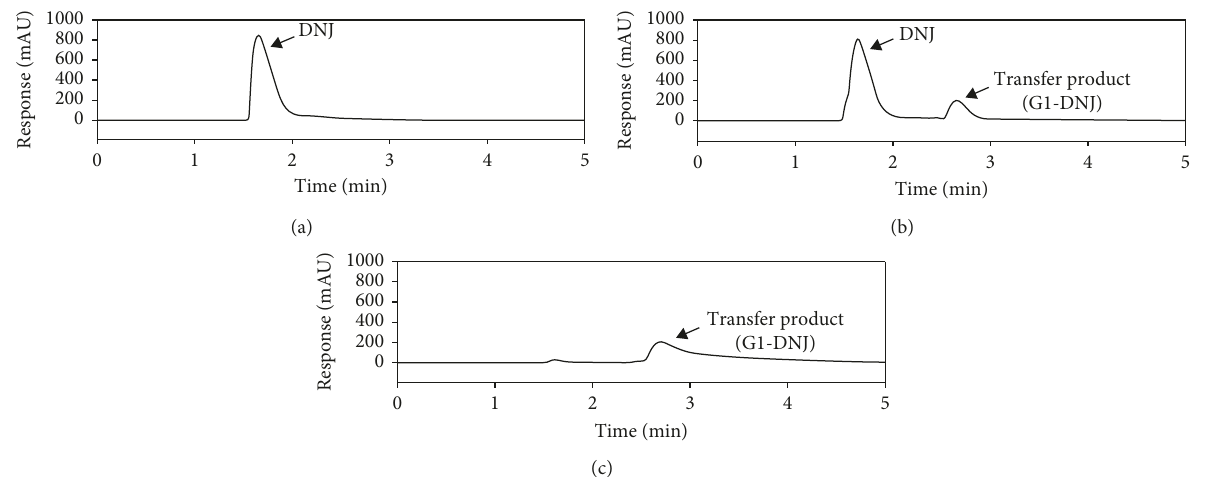
Figure 5: High-performance anion exchange chromatography analysis (HPAEC) chromatograms of DNJ and the transglycosylation product. (a) Before the reaction. (b) After the reaction. (c) The purified transglycosylation product (G1-DNJ).